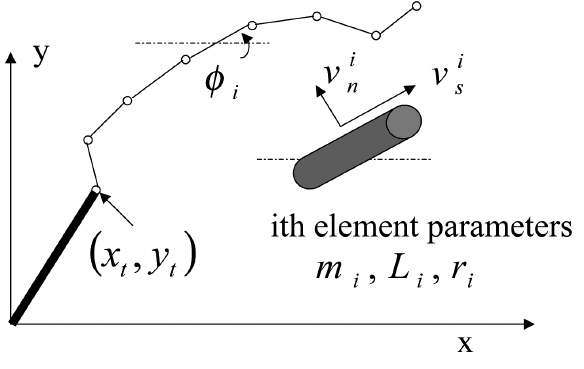
Fig. 3. A lumped parameter fl y line